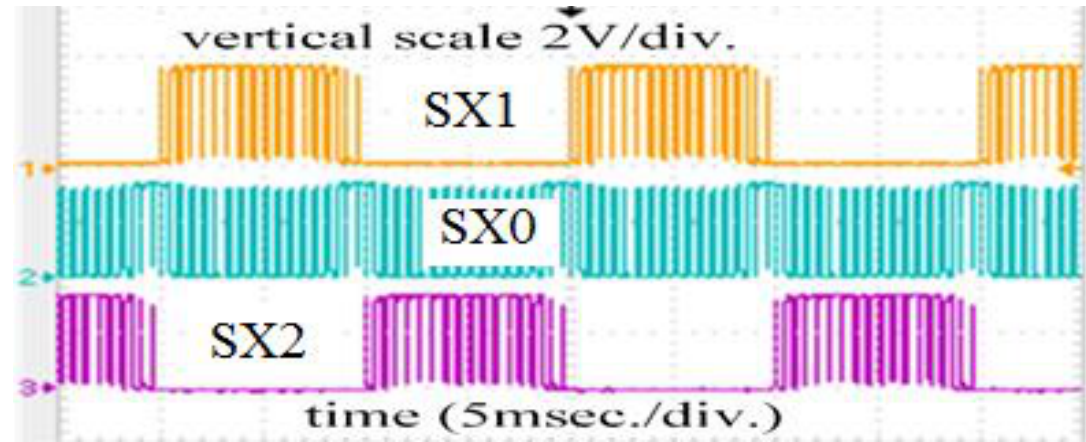
Figure 17. Switching pulses generated from TMS320F28335.